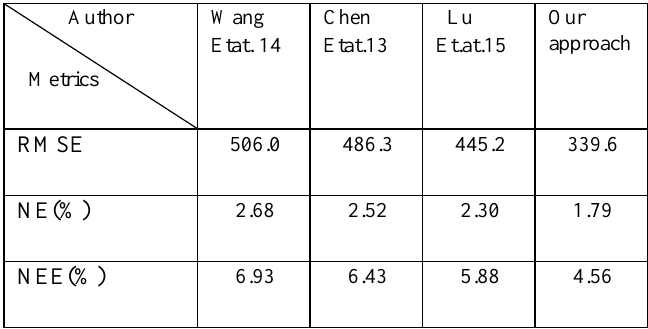
Table 3. shown Metrics of results of the